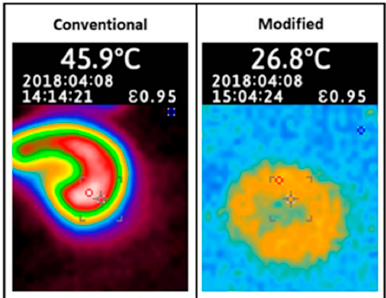
conventional and modified transformer design.